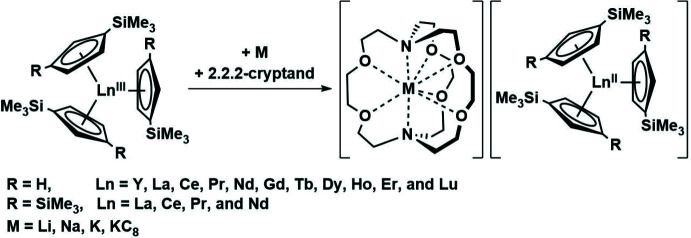
Synthesis of (Cpx
3
Ln
II)1− complexes by alkali metal reduction of Cpx
3
Ln
III precursors; Cpx = C5H4SiMe3, C5H3(SiMe3)2.